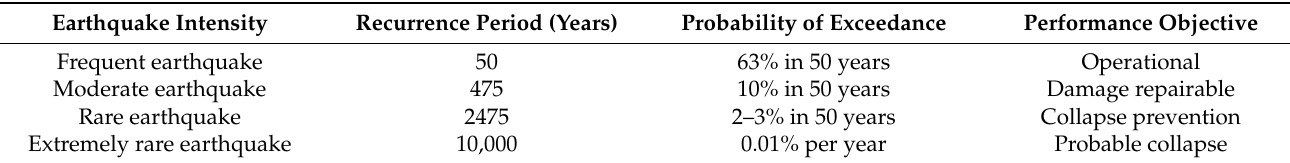
Table 1. Design earthquake intensities and performance objectives in Chinese